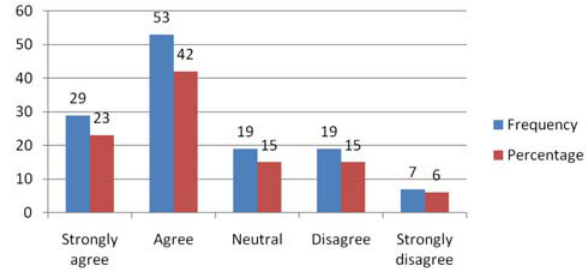
Fig. 6. Government regulations and requirements